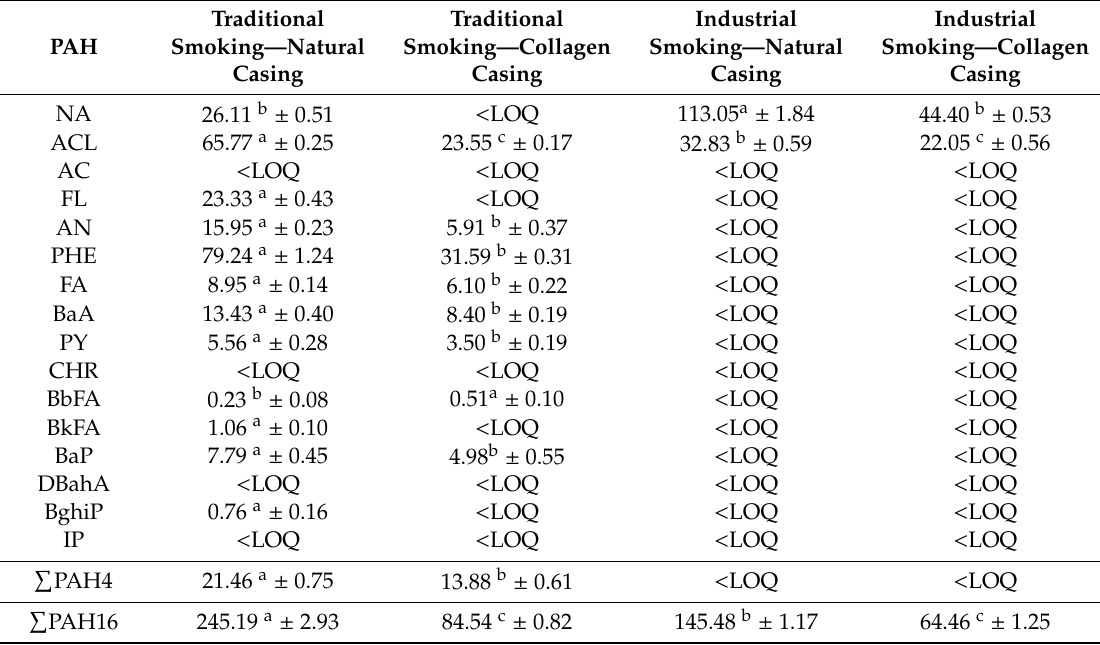
Table 2. PAH contents ( µ g / kg) in Hercegovaˇcka kobasica.